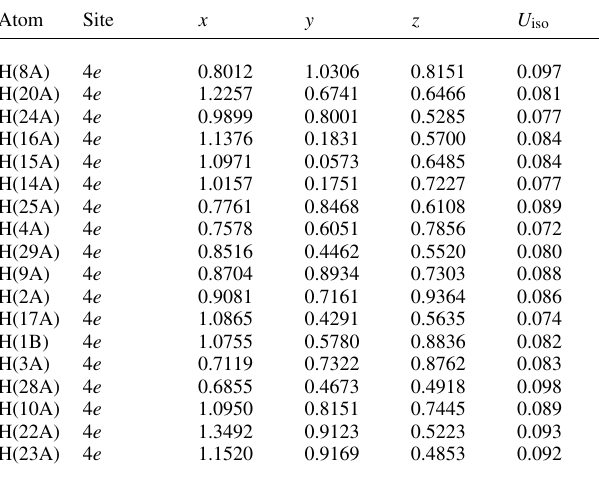
Table 2. Atomic coordinates and displacement parameters (in Å 2 )